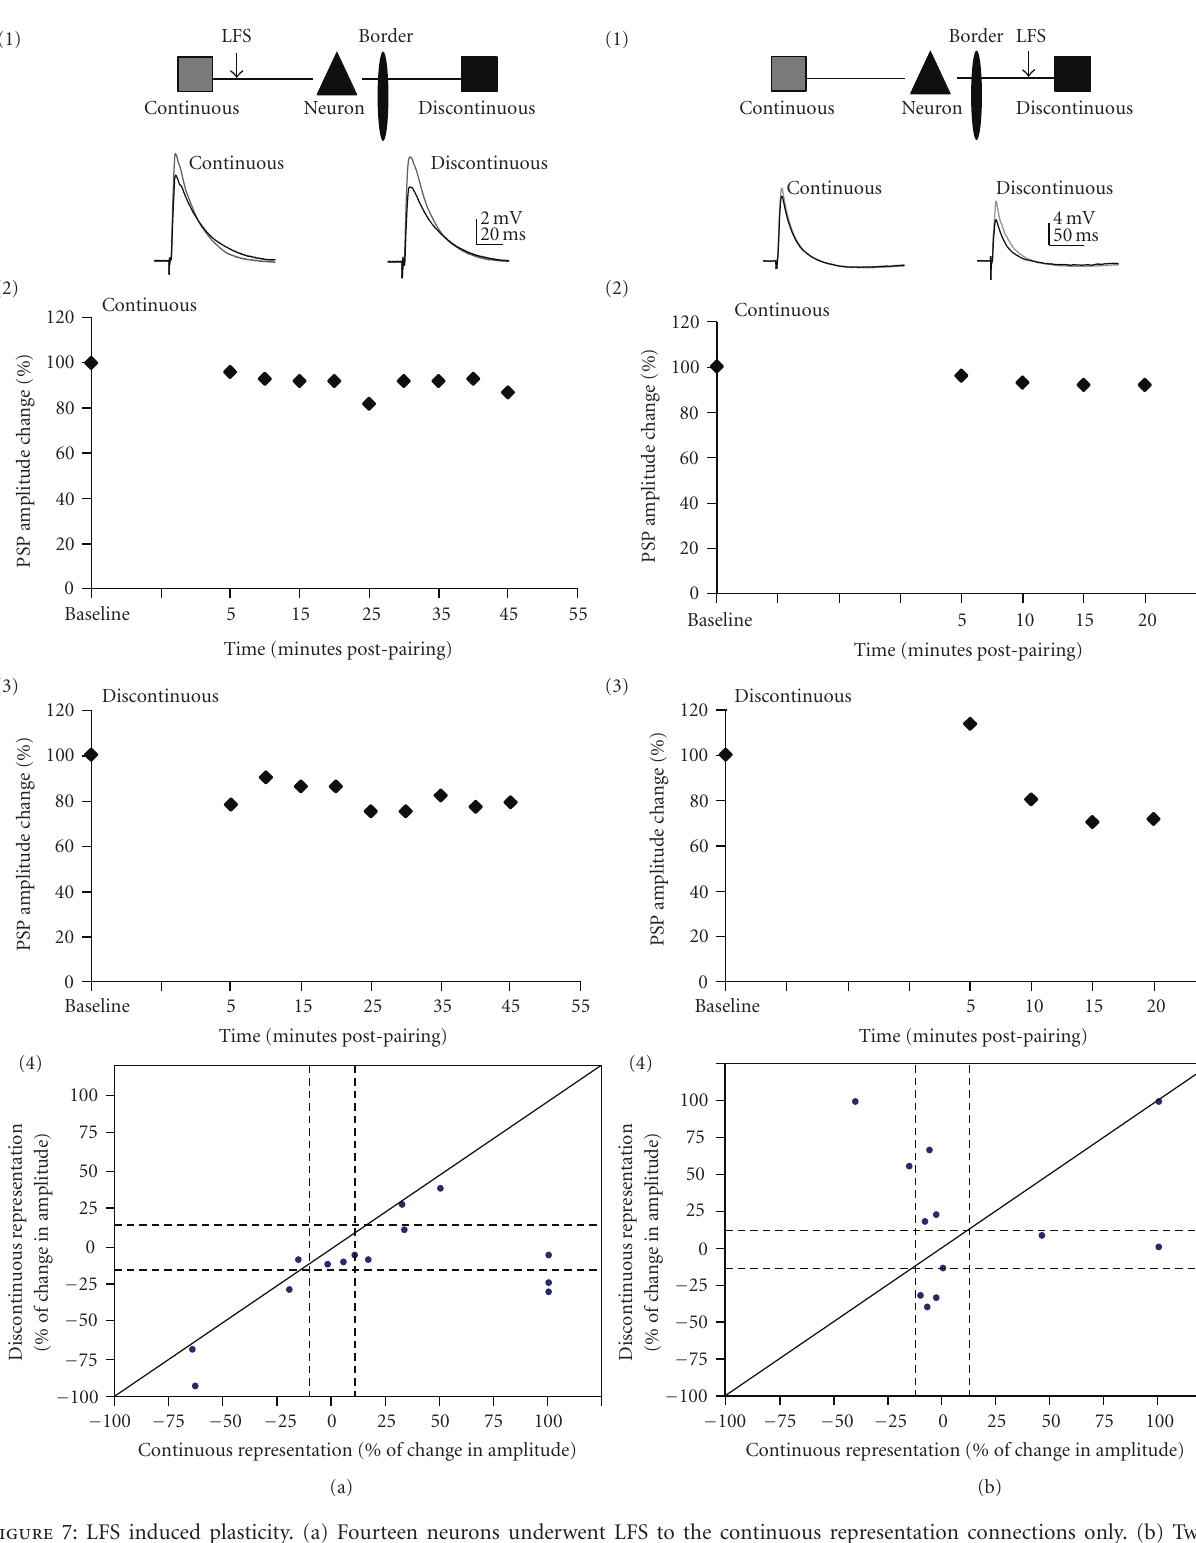
Figure 7: LFS induced plasticity. (a) Fourteen neurons underwent LFS to the continuous representation connections only. (b) Twelve neurons underwent LFS of discontinuous representation connections only. (1) Schematic drawing of the in vitro preparation. (2) Example responses from sample cells. Traces are averaged over five minutes with grey showing PSPs from before pairing (baseline) and black showing those from 20 minutes postpairing. (3): % change of PSP amplitude over time for the cell shown in (2). PSP amplitude change was averaged over five minute intervals. (4) Change in PSP amplitude (expressed as percent of the baseline PSP amplitude) for continuous representation pathway plotted against discontinuous representation pathway for each cell. Solid diagonal line depicts slope of one. Dashed lines depict 15% above and below no change